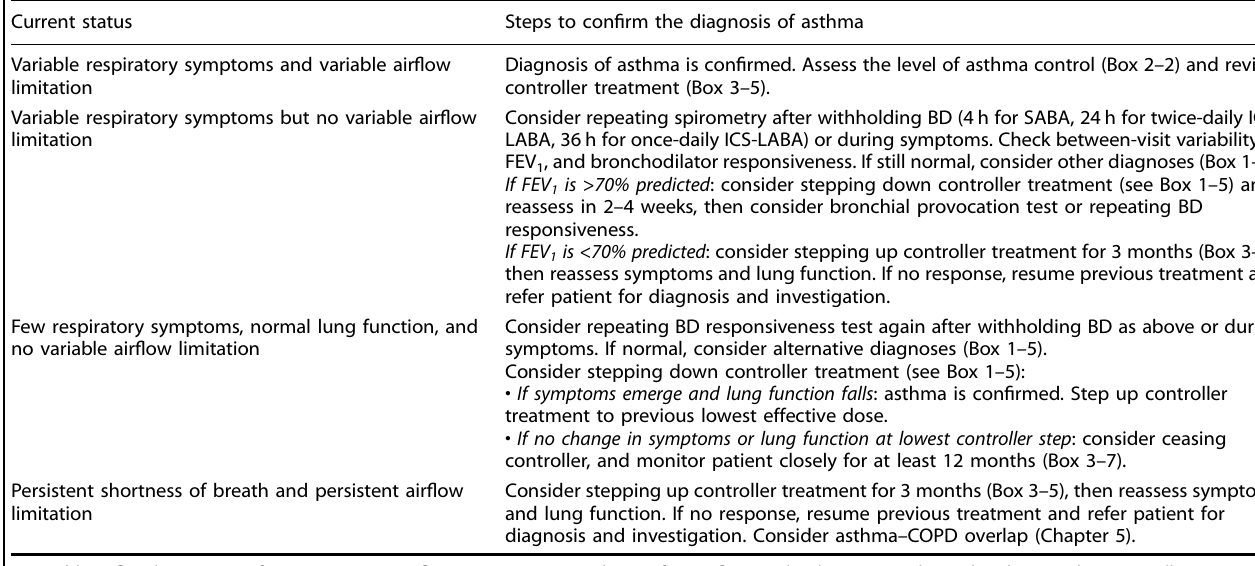
Table 3. Steps for con fi rming the diagnosis of asthma in a patient already taking controller treatment.